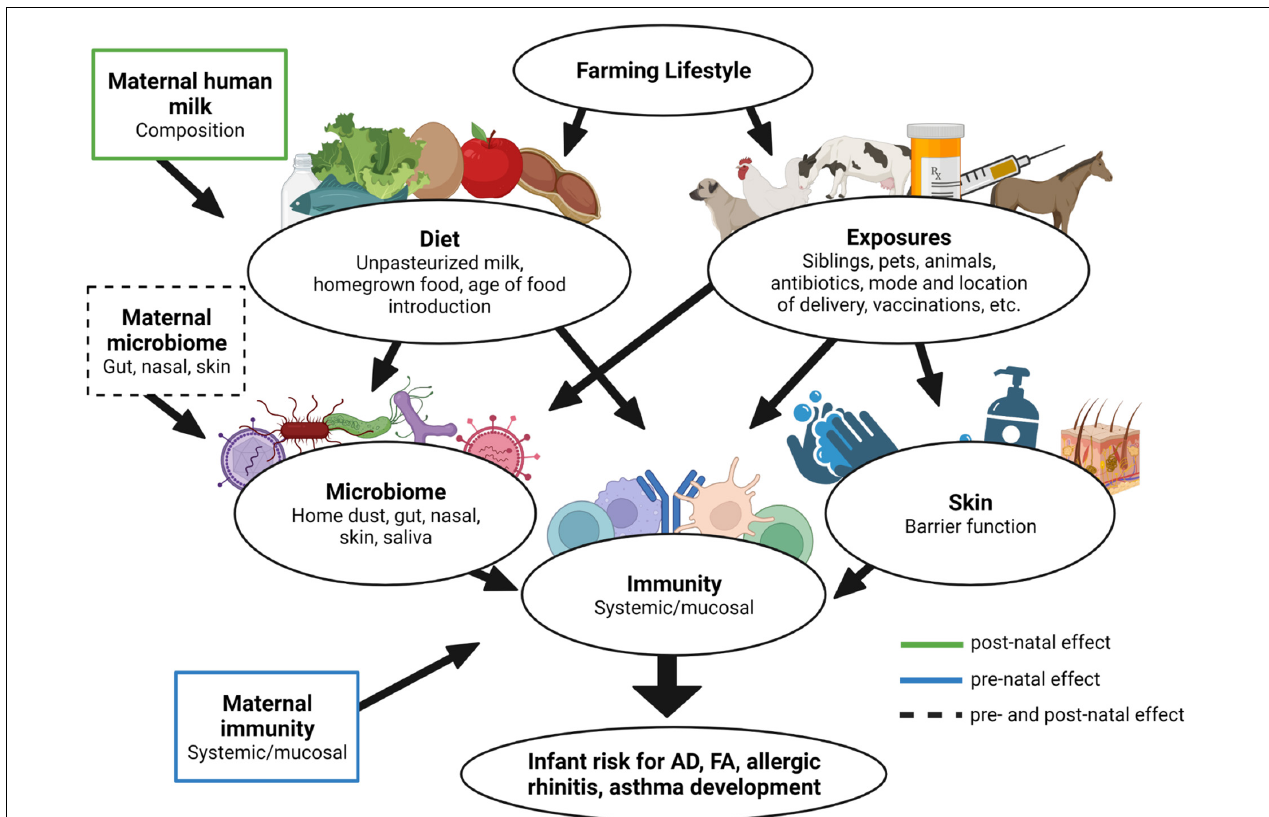
FIGURE 5 | Farm lifestyle impact on development of allergy in early life. Differential diet and microbial exposures due to the farm lifestyle can influence several aspects of infant well-being. Moreover, aspects of the maternal lifestyle can additionally contribute during pre- and postnatal periods, ultimately modulating infant immune function and risk for the development of